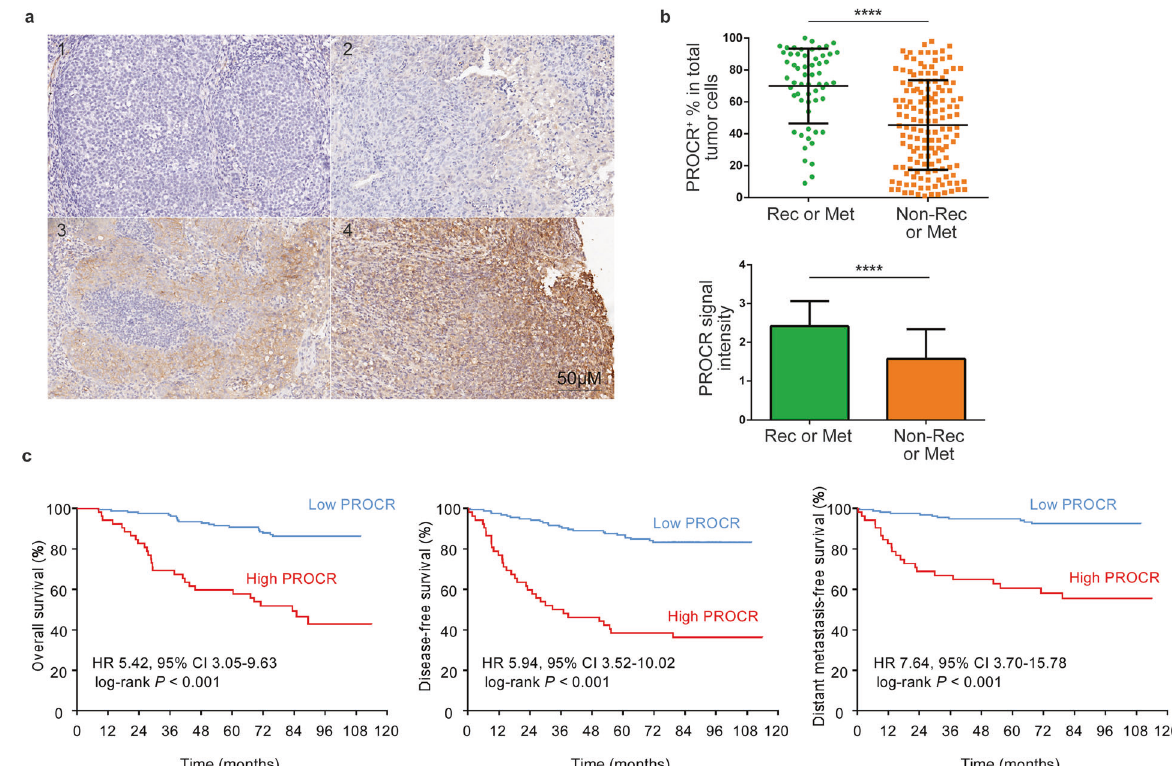
Fig. 6 PROCR serves as an important prognostic factor in NPC. a PROCR expression in sectioned NPC biopsy samples embedded in paraf fi n. According to the staining intensity, a total of 207 samples were divided into four groups denoted by 0 to 3. b Quanti fi cation of the PROCR expression level in metastatic or recurrent patients ( n = 58) versus non - metastatic or non-recurrent patients ( n = 149) based on IHC staining. The upper panel shows the proportion of PROCR + tumor cells versus total tumor cells in each sample in different groups. The lower panel shows the average staining intensity of PROCR in different sample groups. **** P < 0.0001. c Kaplan – Meier curves for patients ’ overall survival, disease-free survival, and distant metastasis-free survival according to PROCR expression (PROCR + cells %). X-tile software was used to generate the optimal cut-off value to stratify patients at different risks. In total, 155 (74.9%) patients had a low PROCR, while 52 (25.1%) patients had a high